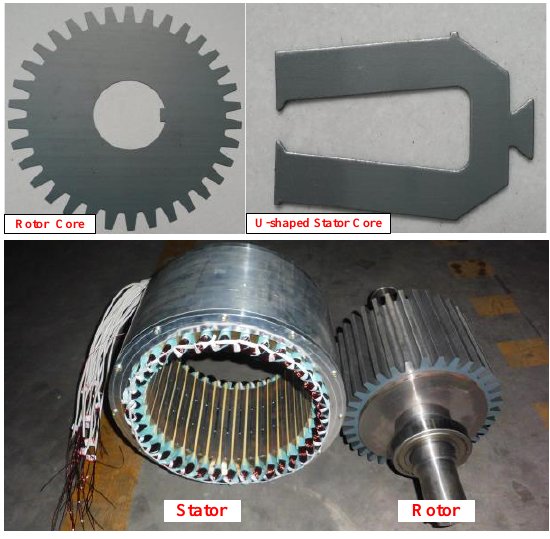
Figure 10. Rotor core and stator core of the prototype.